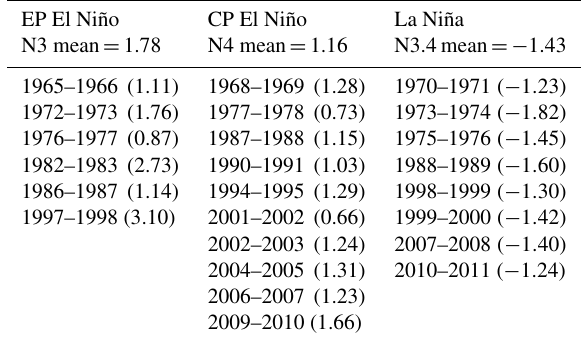
Table 1. Identified EP El Niño, CP El Niño and La Niña events. Numbers in parentheses indicate the value of the El Niño index used for selection in each case (N3 for EP, N4 for CP and N3.4 for La